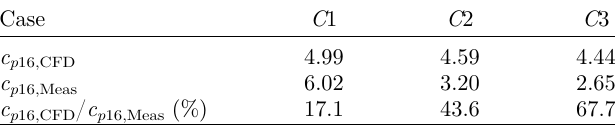
Figure 5. Pressure loss coef fi cients c pL ¼ (cid:1) p L = 1 entire domain and between individual axial positions K 2, K 3, and K Table 3. Pressure loss coef fi cients and relative error.